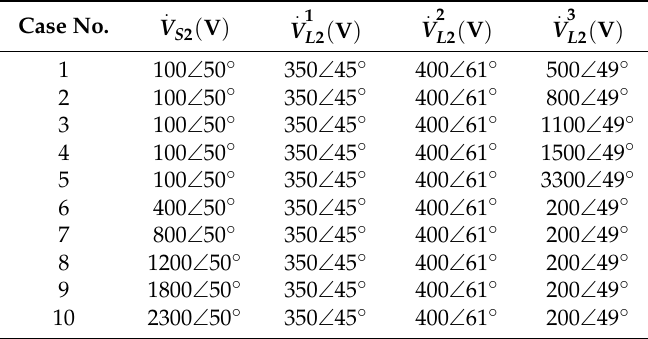
Table 3. Voltage source variation parameters for the case